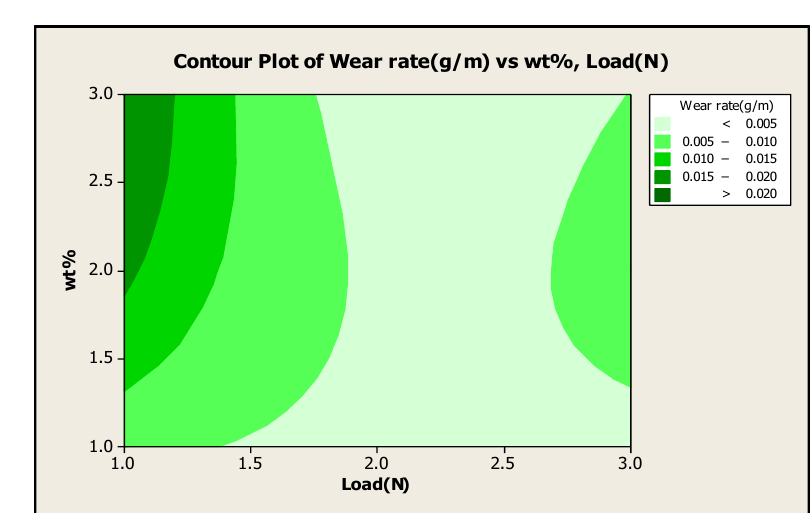
Figure 19: Contour plot of wear rate against weight % and load at high speed.